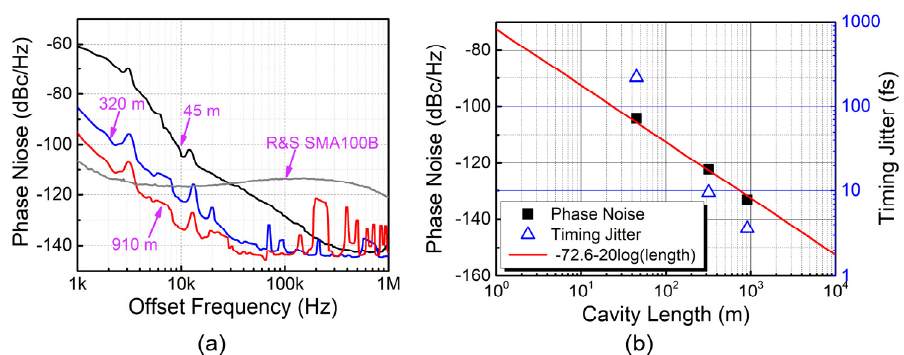
Figure 4. The 25-gigahertz regenerative mode − locked laser with 45-m, 320-m, and 910-m single − mode fiber ( a ) phase noises; ( b ) timing jitter (blue triangle), phase noise at a 10-kilohertz offset from the center frequency (black square), phase noise fitting curve of loop length (red line).